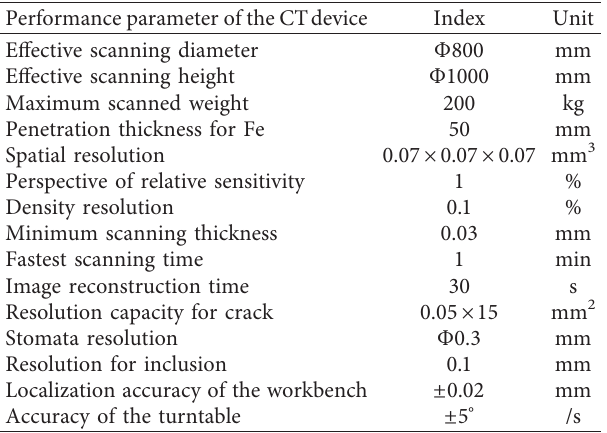
Figure 1: The testing devices for bimrock sample (cited from Wang et al. [28]). (a) Industrial CTmachine with its voltage of 450kV; (b) the loading device to match the CT device. Table 1: The detailed performance index of the 450kV industrial x- ray CT